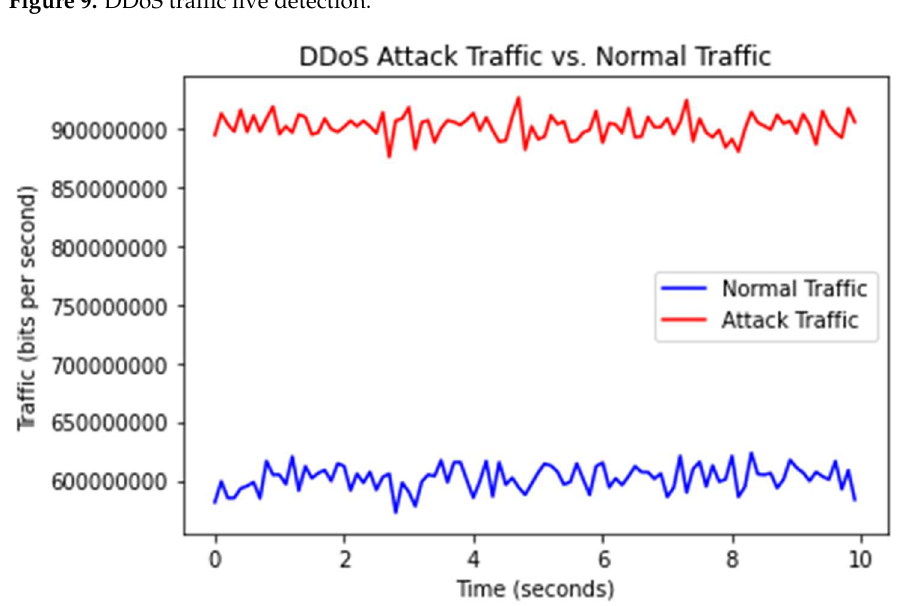
Figure 10. DDoS traffic and normal traffic.